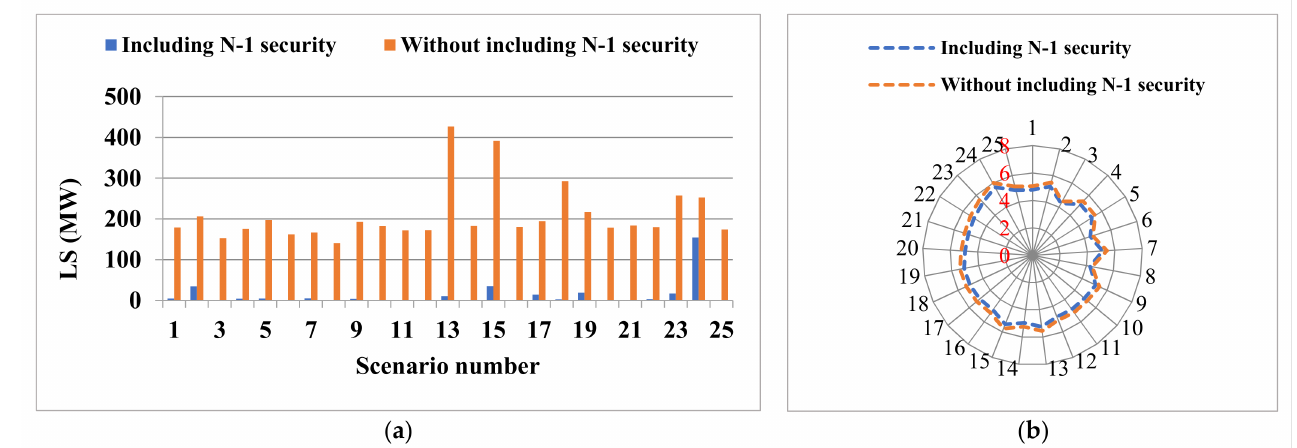
Figure 10. WDN planning with/ without including N-1 security: ( a ) amount of LS for each scenario; ( b ) the contour of maximum short-circuits current for each